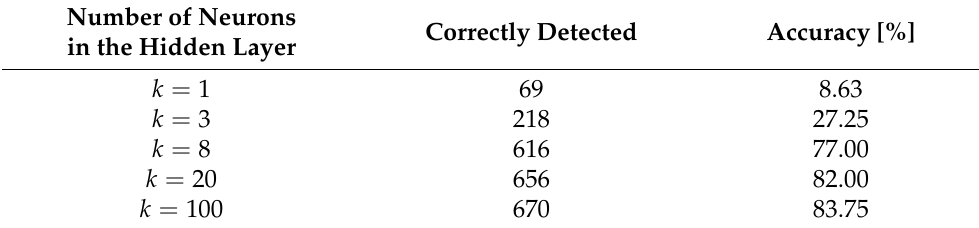
Table 3. Neural network